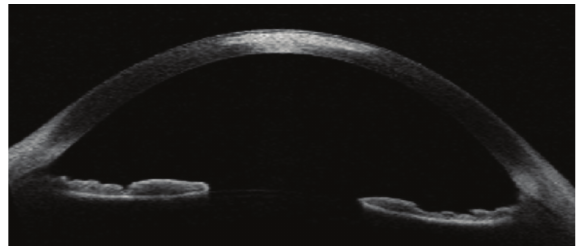
Figure 2: Optical coherence tomography showing corneal scar. The image is helpful in case photorefractive keratectomy is